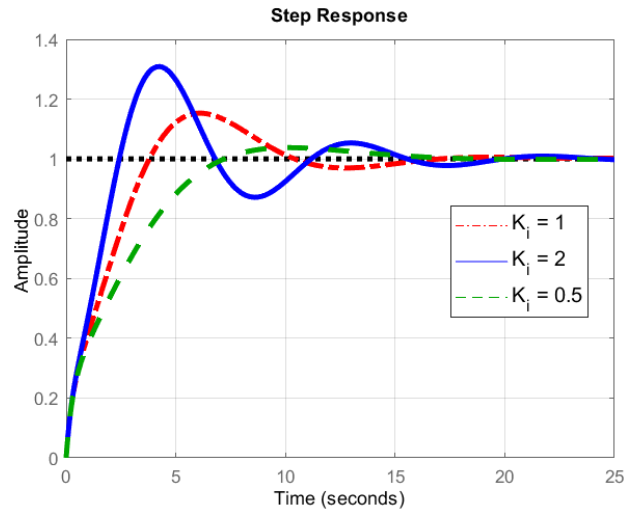
Figure 9. Principle of Integral Controller.